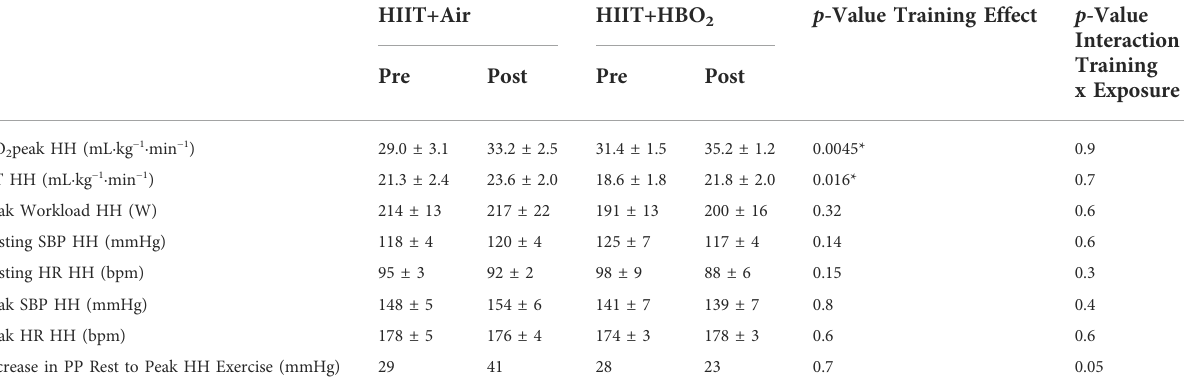
TABLE 2 Physiologic effect of training in all subjects. N = 17. All measurements done during acute hypobaric hypoxia (HH), 429 mmHg barometric pressure (PiO 2 = 0.14) before and after training (mean ± SEM). * p < 0.05. Abbreviations : HH, hypobaric hypoxia; HR, heart rate; PP, pulse pressure; SBP, systolic blood pressure; V _ O 2 peak, peak oxygen uptake; VT, ventilatory threshold by modi fi ed V-slope